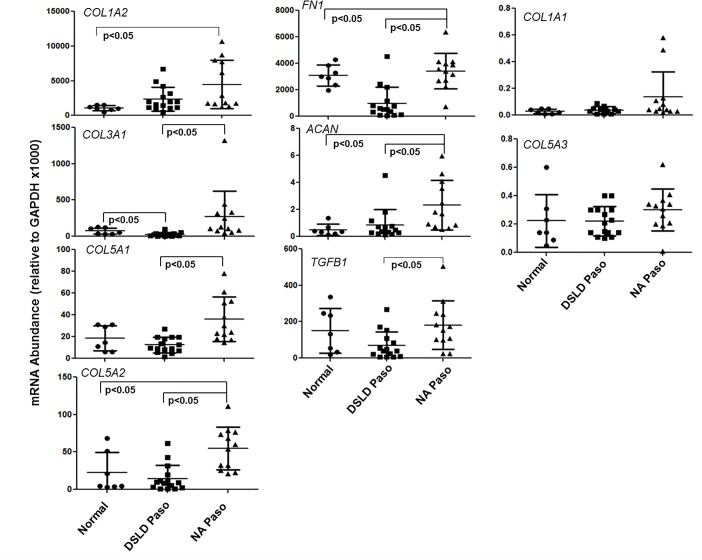
Transcript abundance of ECM remodeling genes in suspensory ligaments.Normals n = 8, DSLD-Pasos n = 15 and NA-Pasos n = 12. Statistical analyses were performed as describe in the Methods Section. Details of horses used for the tissue collection are outlined in S1 Table.